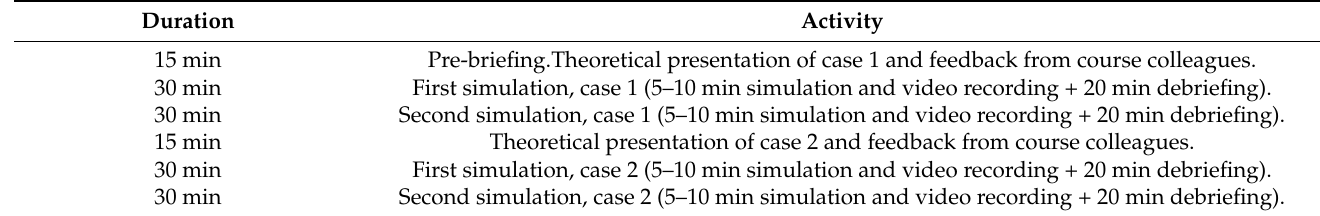
Table 2. Description of the structure of each simulation session (2.5 h). Duration Activity Pre-briefing.Theoretical presentation of case 1 and feedback from course